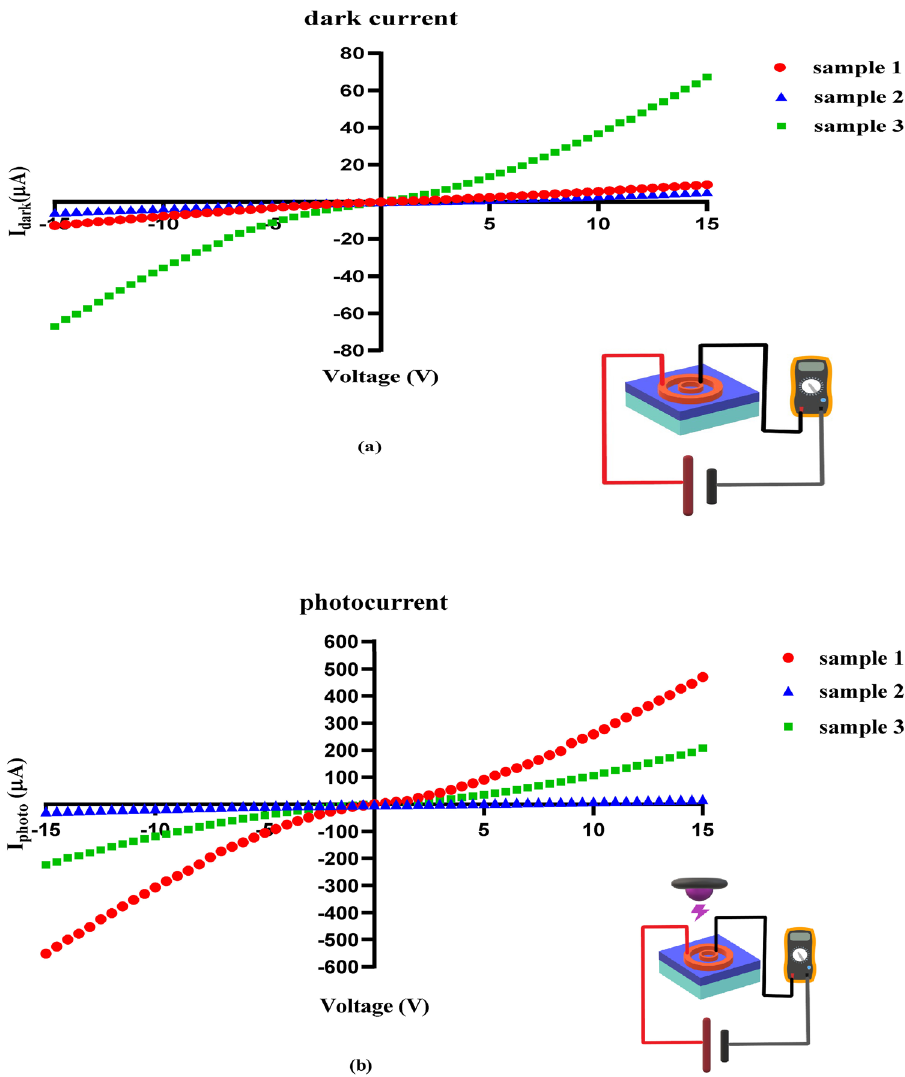
Figure 4. (a) Dark current, (b) photocurrent of flexible UV PDs based on ZnO on the fiberglass (FR4)